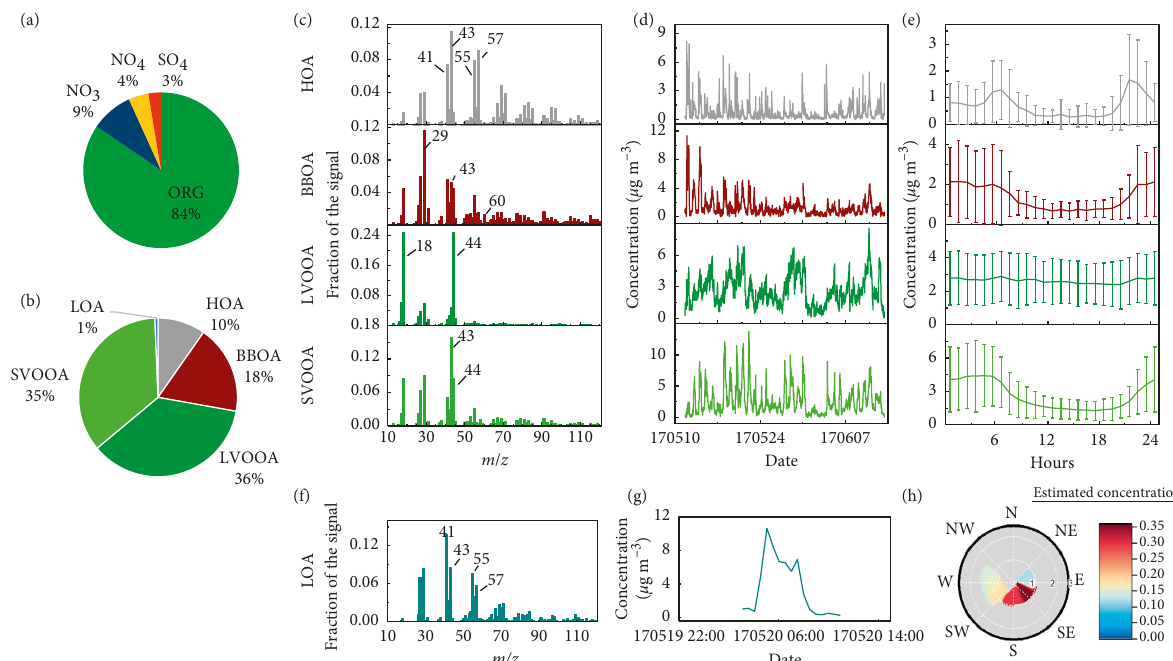
Figure 1: (a) Contributions of organics (green), sulphate (red), nitrate (blue), and ammonium (yellow) during the measurement campaign. (b) PMF solutions contributions to organics: SVOOA (light green), LVOOA (dark green), BBOA (brown), and HOA (grey) factors: (c) their mass spectra; (d) time series; (e) diurnal time trends. LOA: (f) mass spectra; (g) time series; (h) wind rose